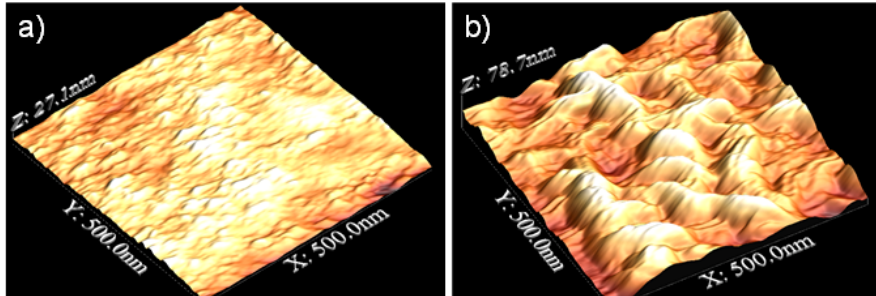
Figure 1. AFM images of AZ31 alloy ( a ) before and ( b ) after 2 min of